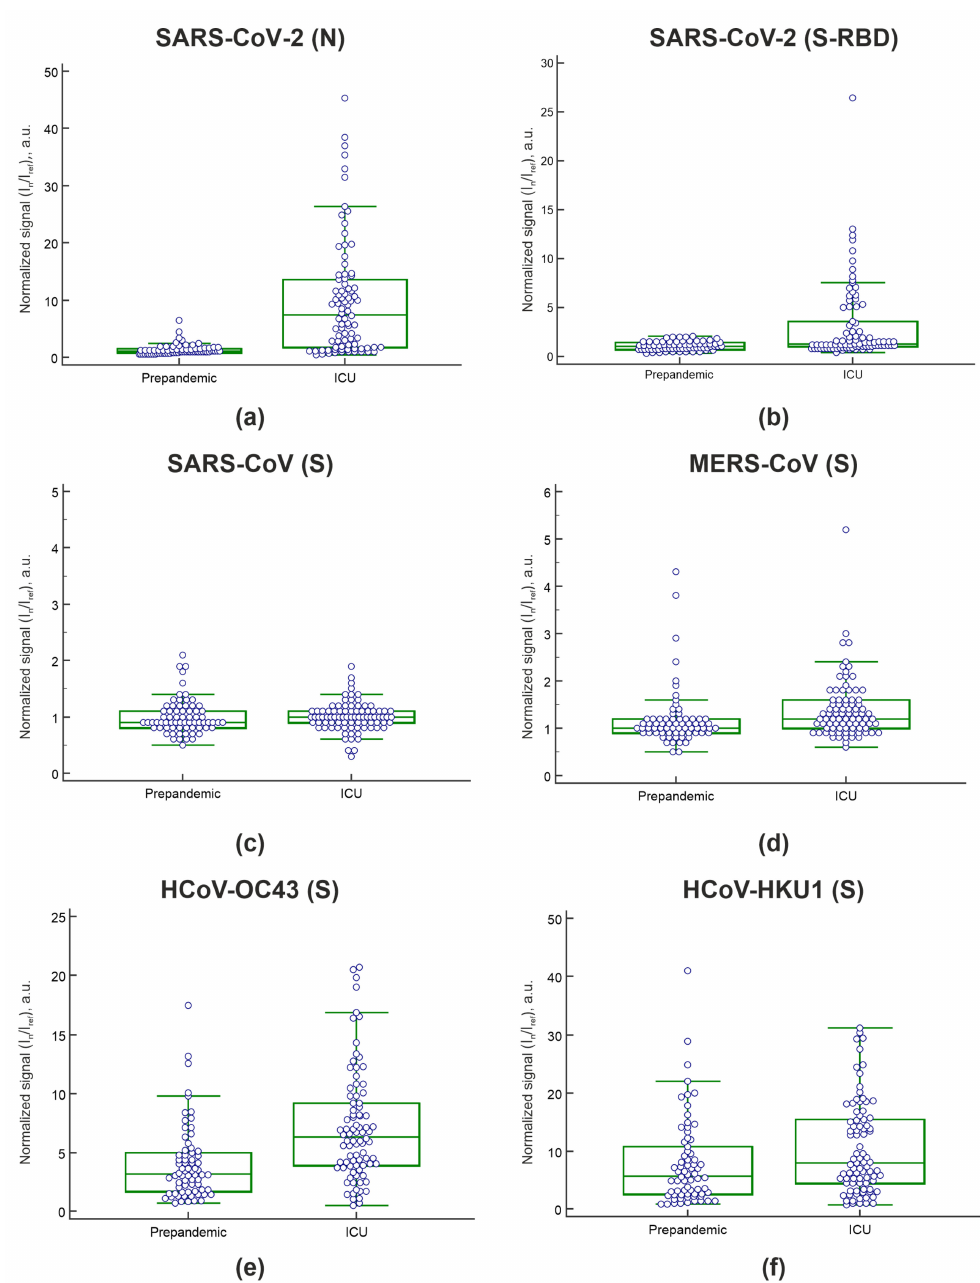
Figure 4. Humoral immune responses to betacoronaviruses in samples from the heterogeneous prepandemic cohort (n = 70) and samples from COVID-19 ICU patients (n = 86). ( a ) IgG against the SARS-CoV-2 nucleocapsid; ( b ) IgG against the SARS-CoV-2 spike RBD; ( c ) IgG against the SARS-CoV spike protein; ( d ) IgG against MERS-CoV spike protein; ( e ) IgG against the OC43 spike protein; ( f ) IgG against the HKU1 spike protein. The whisker plots show the distribution of IgG antibody titers across the prepandemic and ICU patient samples. The dots show the values of each sample. The solid black line indicates the median, and the top and bottom box boundaries indicate the first and third